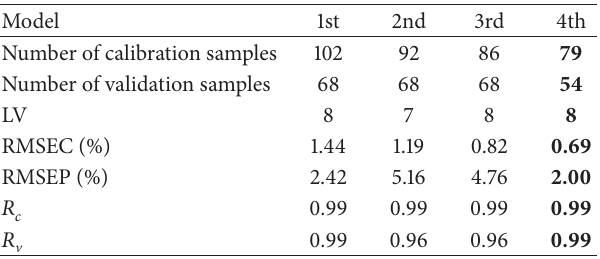
Table 4: Optimization of PLS model by detection and removal of